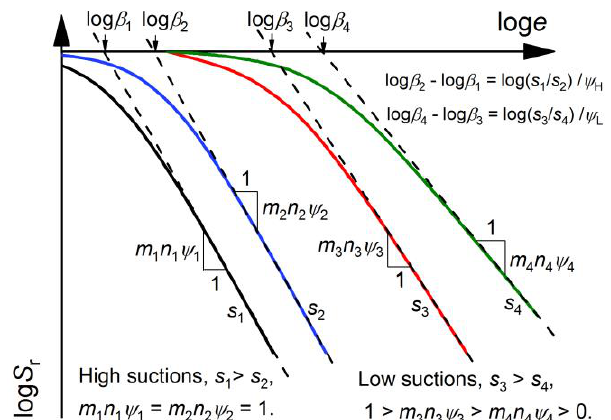
Figure 11. Schematic diagram of the hydro-mechanical coupling curves (HMCCs) with different constant suctions at low suctions and high suctions.